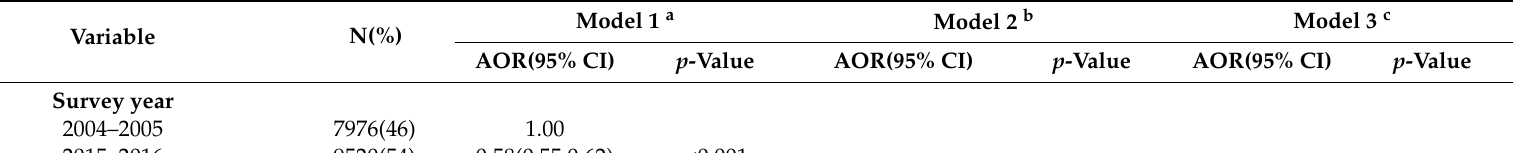
Table 3. Decline in child anemia in relation to other factors using TDHS 2004–2005, TDHS